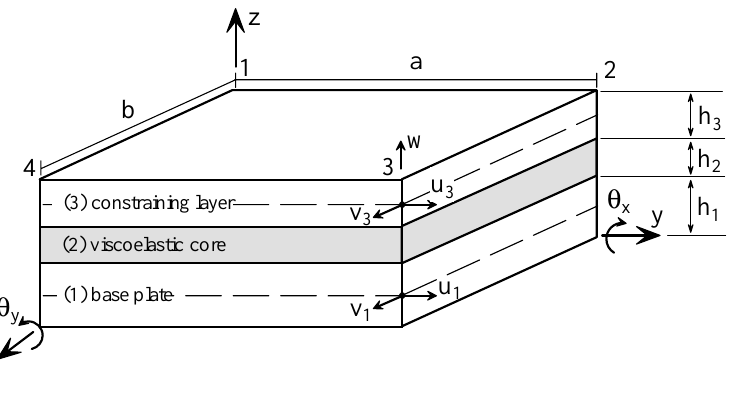
Fig. 2. Three-layer sandwich plate finite